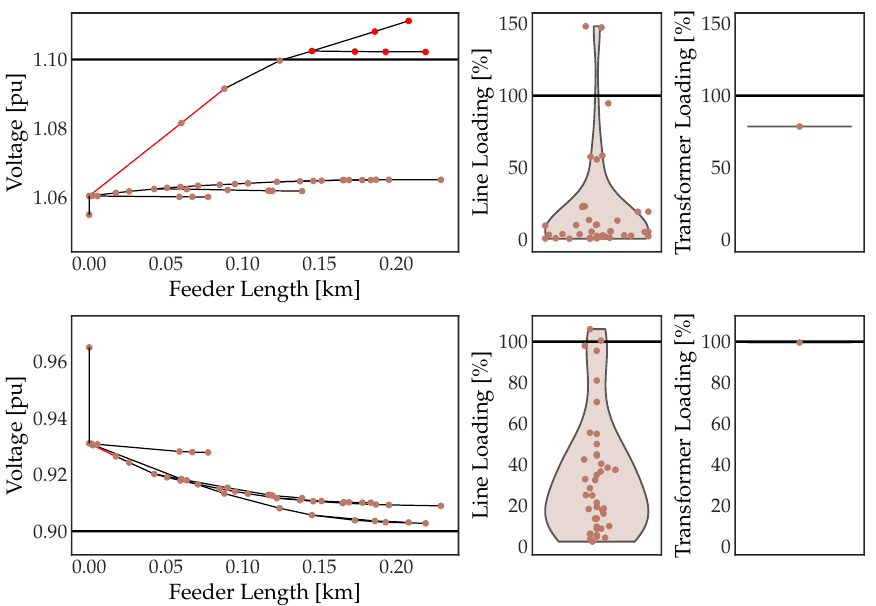
Figure 10. Voltages and loadings of the “1-LV-semiurb4--2-sw” grid at the low load, high generation, extra-high PV generation (lPV, top ) and the high load, low generation (hL, bottom ) study